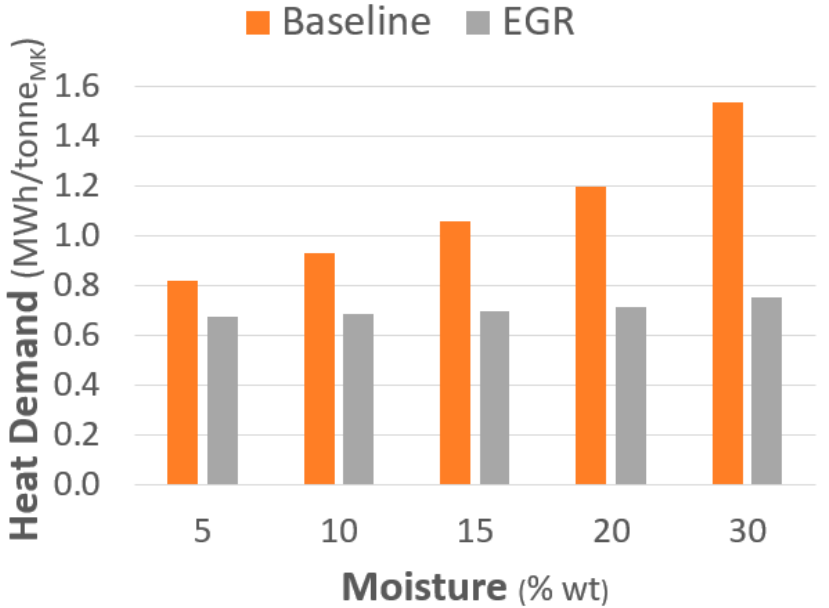
Figure 5. Calculated MK production process heat demand (MWh/tonne MK ). Impact of raw material moisture content. (Fuel: NG; reference kiln temperature: 750 °C).